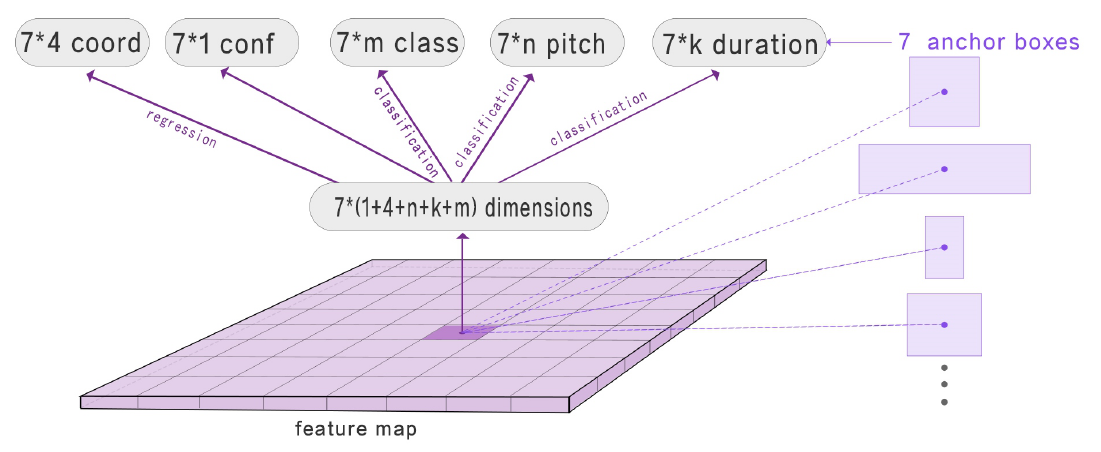
Figure 7. The last layer of the network: the symbol class, pitch, and duration are classified, and the coordinates of the symbol are obtained by